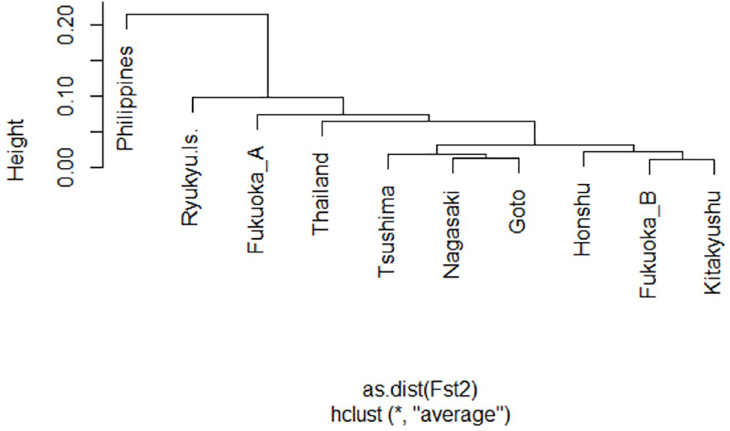
Fig 5. Cluster analysis using F st in ten Ae . albopictus groups consisting of Kyushu, Honshu, and two tropic populations.